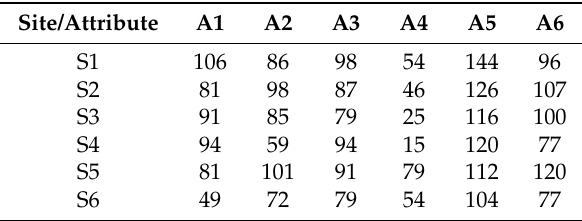
Table 13. Total access cost matrix (TACS).